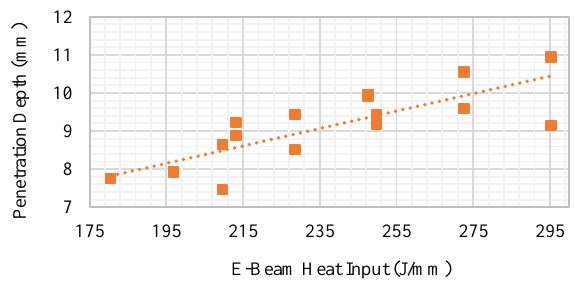
Figure 9: Linear increase in penetration depth with heat